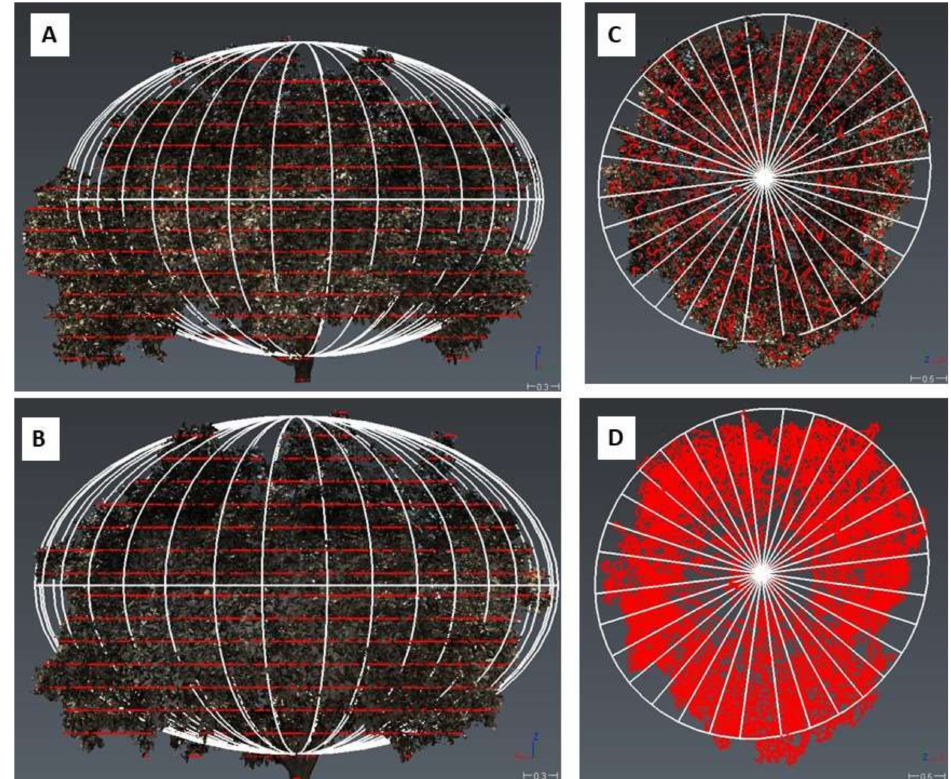
Figure 16. The visual composition of the TM (ellipsoid) and the HDS for tree 7, the red lines mark the cross-sections. ( A ) Frontal view. ( B ) Side view (left-right). ( C ) Top view (with leaves). ( D ) Top view